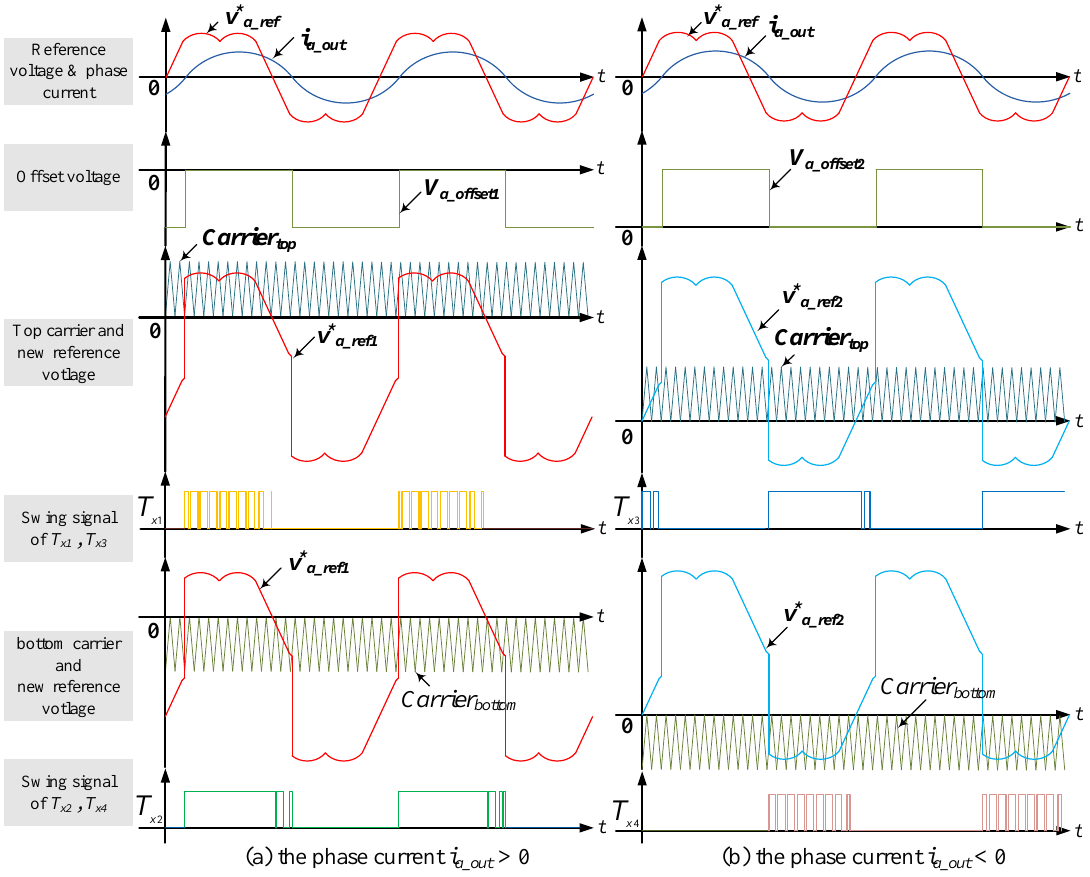
Figure 8. The switching signal and reference voltage waveforms of the proposed zero dead-time width modulation (ZDPWM) method.